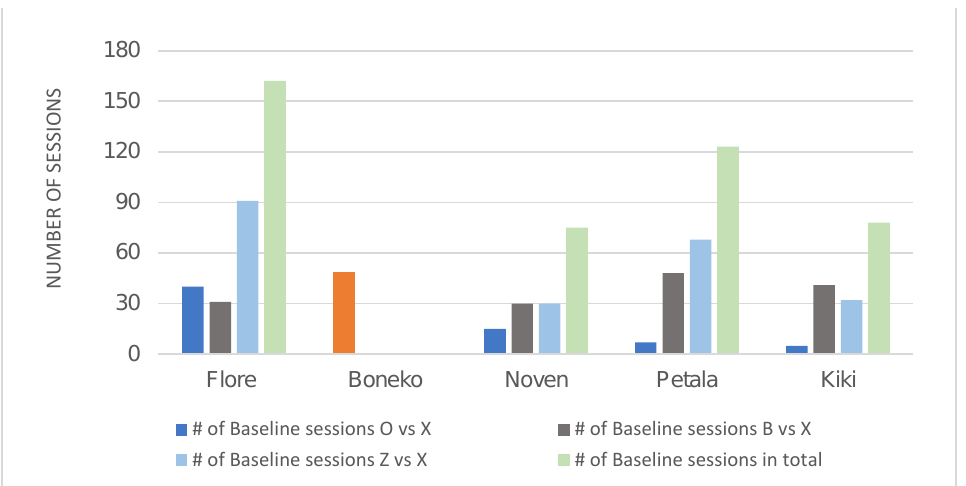
Figure 5. The number of baseline pair discrimination sessions for each horse (see Methods 2-4-4). The male, Boneko (in orange), did not reach the criterion so received no further training. The X -axis shows the horses in decreasing order of age (13, 8, 5, 4, and 2 years old).